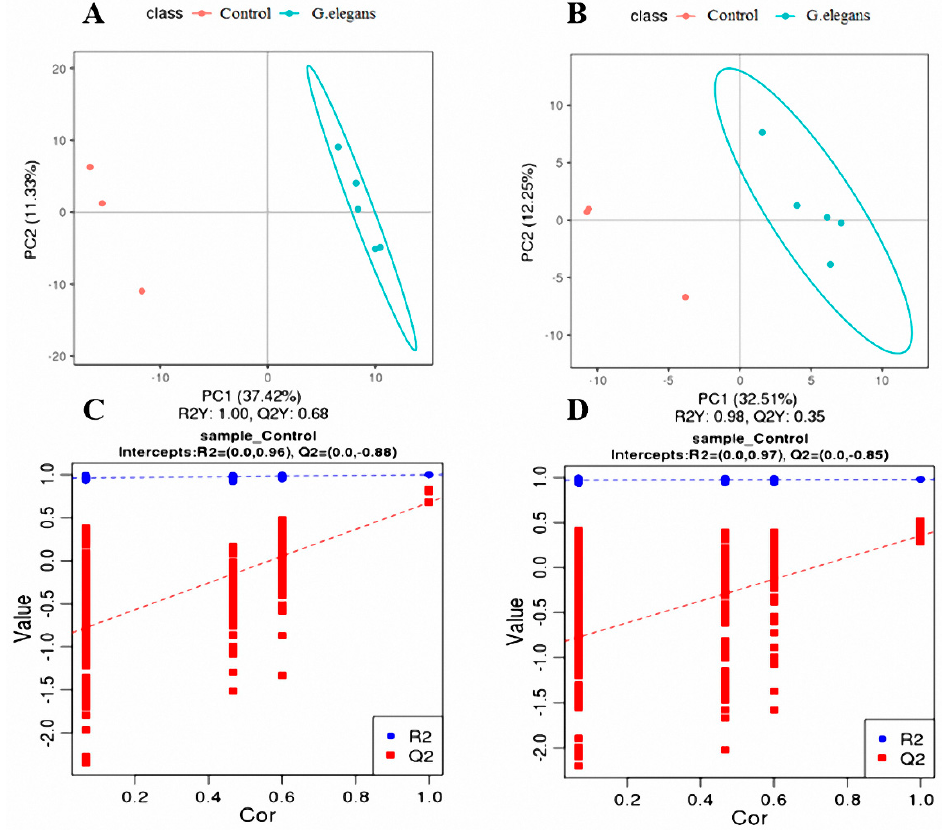
Figure 3. The PLS-DA for scatterplot and sorting verification plot in positive and negative mode. The scatterplot ( A , B ) was obtained. The abscissa is the score of the sample on the first principal component. The ordinate is the score of the sample on the second principal component. R2Y represents the interpretation rate of the second principal component of the model, and Q2Y represents the prediction rate of the model. In the sorting test ( C , D ), the abscissa represents the correlation between the random group Y and the original group Y, and the ordinate represents the score of R2 and